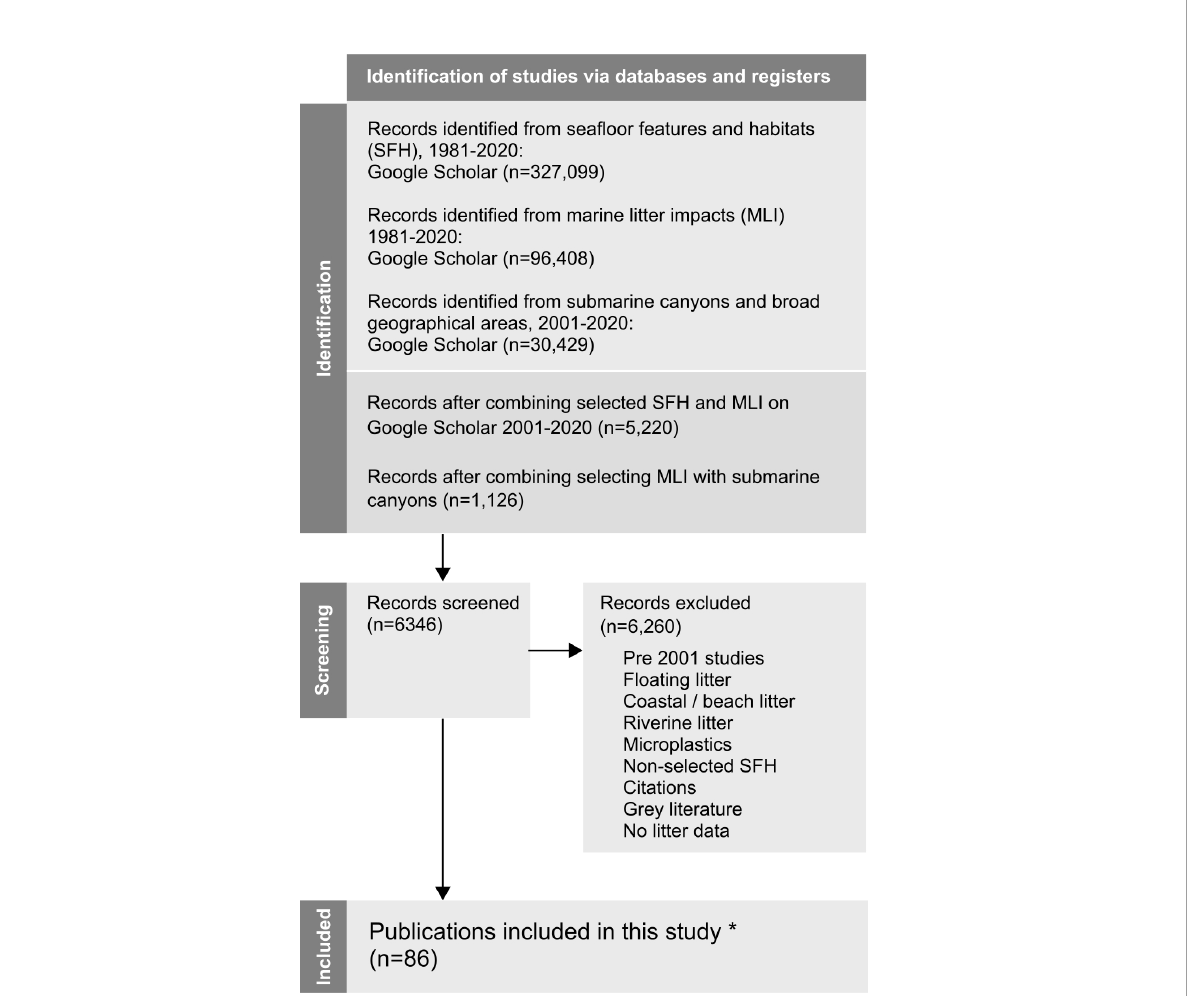
FIGURE 1 Schematic representation of the literature review and critical synthesis to produce a corpus.* Jeong et al., 2005; Lee at al., 2006; Koutsodendris et al., 2008; Barnes et al., 2009; Keller et al., 2010; Topc ̧ u and Öztürk, 2010; Watters et al., 2010; Miyake et al., 2011; Mordecai et al., 2011; Bergmann and Klages, 2012; Wei et al., 2012; Güven et al., 2013; Lefkaditou et al., 2013; Mifsud et al., 2013; Pham et al., 2013; Purser et al., 2013; Ramirez-Llodra et al., 2013; Sa ́ nchez et al., 2013; Schlining et al., 2013; Bo et al., 2014; Debrot et al., 2014; Eryas ̧ ar et al., 2014; Fabri et al., 2014; Ioakeimidis et al., 2014; Pham et al., 2014; Angiolillo et al., 2015; Fiorentino et al., 2015; Goto and Shibata, 2015; Ioakeimidis et al., 2015; Neves et al., 2015; Oliveira et al., 2015; Papadopoulou et al., 2015; Strafella et al., 2015; Tubau et al., 2015; Vieira et al., 2015; Woodall et al., 2015; Yamakita et al., 2015; Lastras et al., 2016; Moriarty et al., 2016; Pasquini et al., 2016; Shimanaga and Yanaghi., 2016; Buhl-Mortensen and Buhl- Mortensen, 2017; Cau et al., 2017; García-Rivera et al., 2017; Lopez-Lopez et al., 2017; Louald et al., 2017; Rodríguez and Pham, 2017; Tekman et al., 2017; van den Beld., 2017; Alvito et al., 2018; Baudrier et al., 2018; Cau et al., 2018; Chiba et al., 2018; Consoli et al., 2018b; Domingiez Carrió, 2018; Ferrigno et al., 2018; García-Rivera et al., 2018; Grøsvik et al., 2018; Kammann et al., 2018; Maes et al., 2018; Olguner et al., 2018; Urban-Malinga et al., 2018; Consoli et al., 2019; Fortibuoni et al., 2019; Gerigny et al., 2019; Giusti et al., 2019; Peng et al., 2019; Pierdomenico et al., 2019a; Pierdomenico et al., 2019b; Rhinane and Loulad, 2019; Spedicato et al., 2019; Strafella et al., 2019; Zablotski and Kraak, 2019; Alomar et al., 2020; Amon et al., 2020; Botero, et al., 2020; Consoli et al., 2020; Crocetta et al., 2020; Du Preez et al., 2020; Enrichetti et al., 2020; Garofalo et al., 2020; Grinyó et al., 2020; Kuroda et al., 2020; Mecho et al., 2020; Pierdomenico et al., 2020 and Ryan et al.,